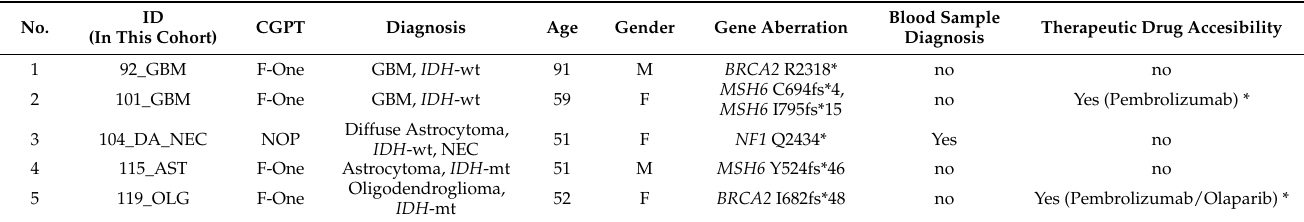
Table 3. Presumed germline mutations based on the CGPT